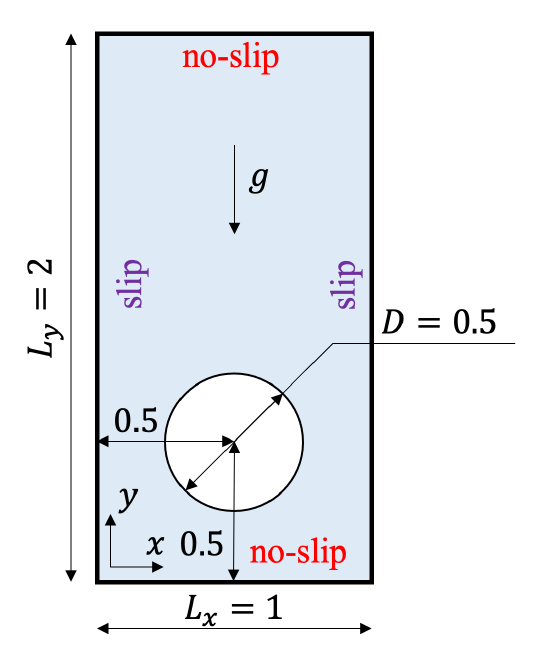
Figure 10. A schematic diagram of the two-dimensional rising bubble problem as a benchmark test. The region in light blue is occupied by heavy fluid and the region in white is occupied by light fluid. Table 1. Physical properties of the two-dimensional rising bubble problem. Case ρ